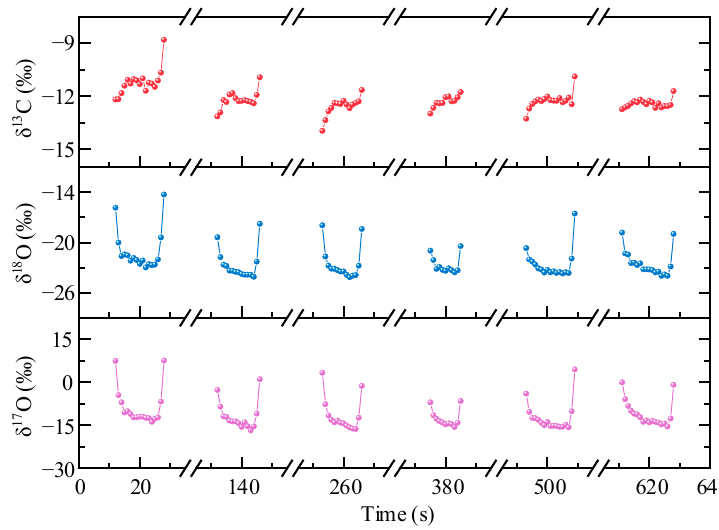
Figure 10. Real-time measurement of the exhaled δ 13 C, δ 18 O, and δ 17